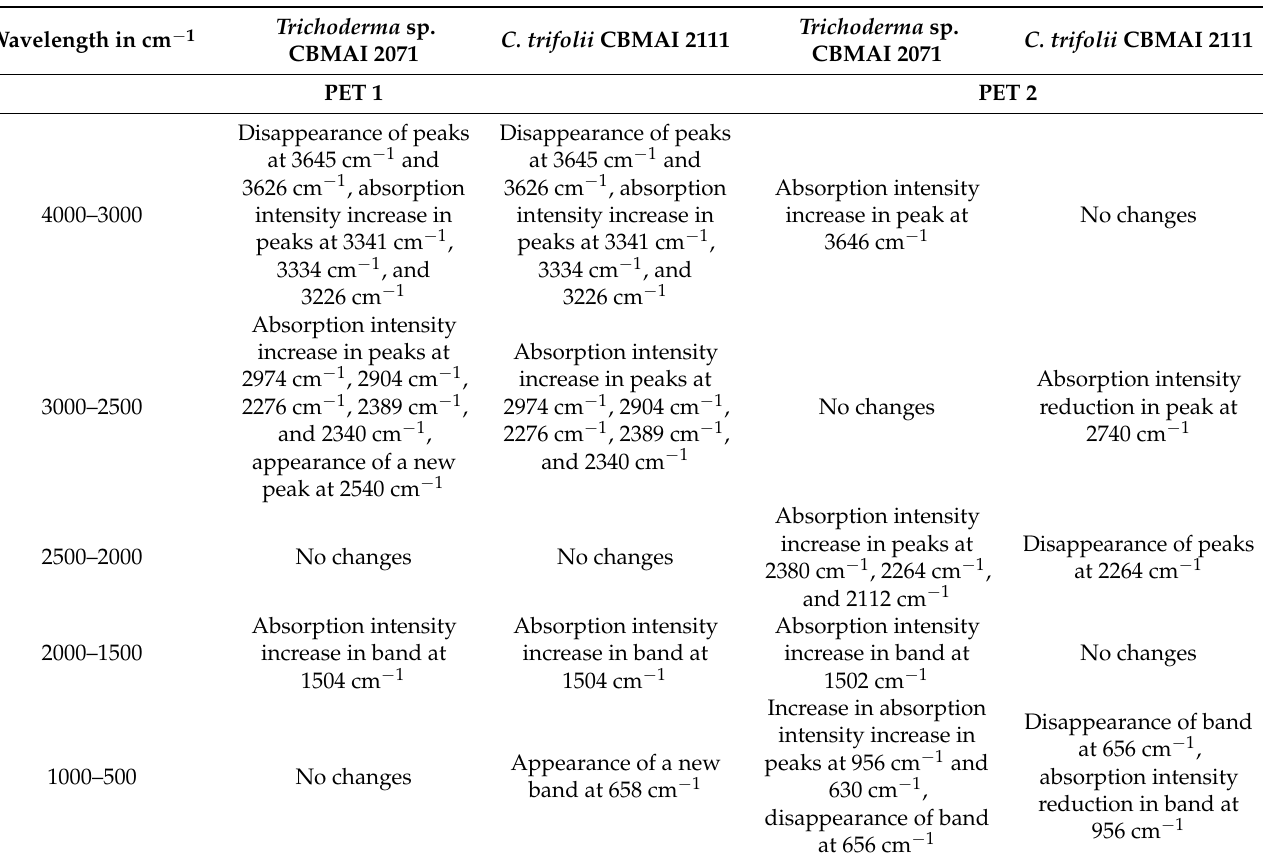
Figure 10. FTIR spectra for PET1 and PET2 obtained after 15 days in contact with C. trifolii CBMAI 2111 and Trichoderma sp . CBMAI 2071. Culture media PDB, t = 28 °C, 150 rpm. The FTIR analysis was performed in duplicate treatments, indicated as A and B in the figure. Figure S4 (A–H) in the supplementary material contains the FTIR spectra in the zoomed view for the best observation of the alterations promoted by the treatments. Table 9. Polymeric modifications on PET1 and PET2 after fermentation with T. sp. and C. trifolii using FTIR